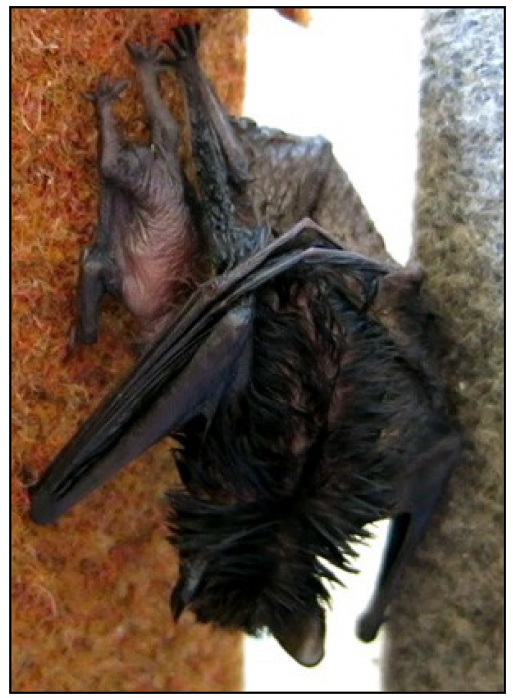
Figure 1. Adult female common pipistrelle ( Pipistrellus pipistrel- lus ) with her newborn pup (Burgdorf, Germany, June 2014). Photo by Bernd Rose, NABU Burgdorf, used with